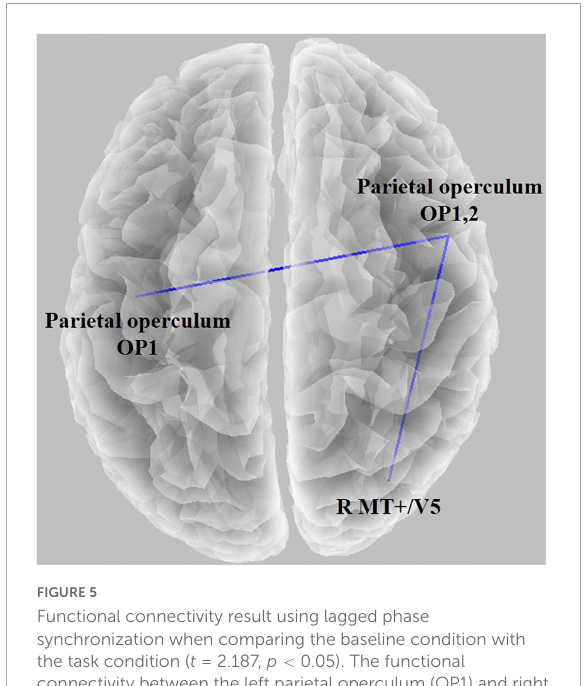
FIGURE5 Functional connectivity result using lagged phase synchronization when comparing the baseline condition with the task condition ( t = 2.187, p < 0.05). The functional connectivity between the left parietal operculum (OP1) and right parietal operculum (OP2) decreased, and connectivity between OP2 and the right medial temporal area (V5)